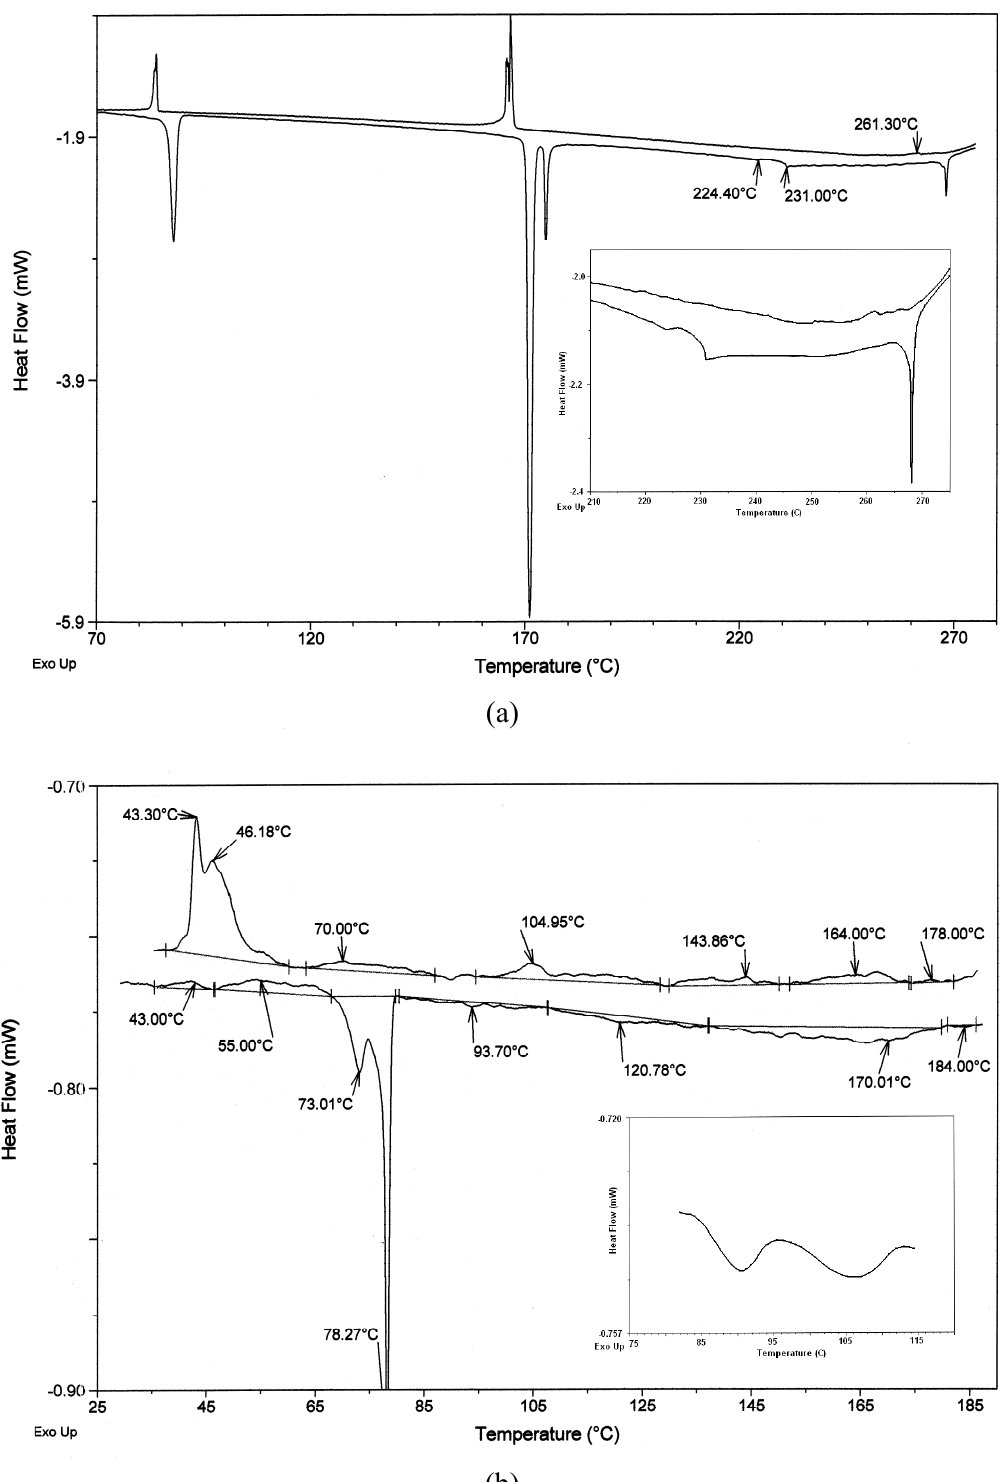
Figure 3. (a) DSC traces of symmetrical azomethine A1 at a heating/cooling (h/c) rate of 2 ° C/min. (b) DSC traces of unsymmetrical azomethine AP1A at a h/c rate of 0.8 ° C/min (inset heating 2 ° C/min from 80 ° C to 118 °